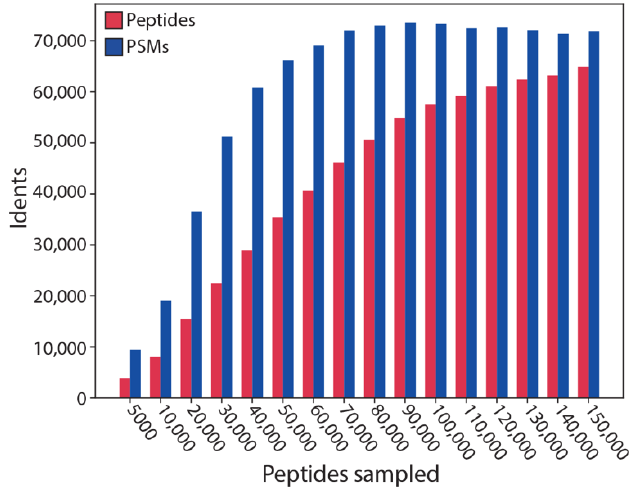
Figure 6. Performance test of SMITER simulation. The tryptic peptides of a full yeast proteome were simulated; different numbers of peptides were randomly sampled and analyzed using X!Tandem and Percolator. The number of identified peptide spectrum matches (PSM) and of identified peptides are indicated in response to the number of sampled peptides.